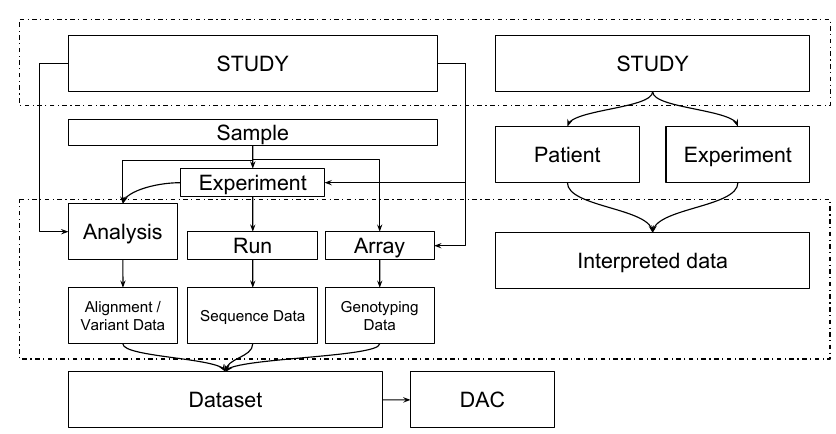
Figure 2. Metadata mapping between EGA and tranSMART. The data model of EGA is dramatically different from that of tranSMART (v16.1) due to the deviating purposes and designs of the systems. Furthermore, in both systems, there is an intrinsic flexibility in defining the data model. EGA uses the SRA (sequence read archive) data model for NGS data with the addition of array data from array and genotyping experiments. EGA also exports all sample objects to BioSamples, ensuring each sample has a BioSample ID. tranSMART focuses on the clinical information and interpreted biomolecular profiling data. The data model has a patient-centered, but flexible structure which also shows some design choices due to the underlying relational database. Terminology is not the same between tranSMART and EGA - partially due to the SRA data model employed at EGA, such that an experiment describes the library and platform used for sequencing experiments only. In tranSMART, a wider range of experiments can be described. DAC is a data access committee. The sample level, which is lacking in tranSMART v16.1, will be supported from